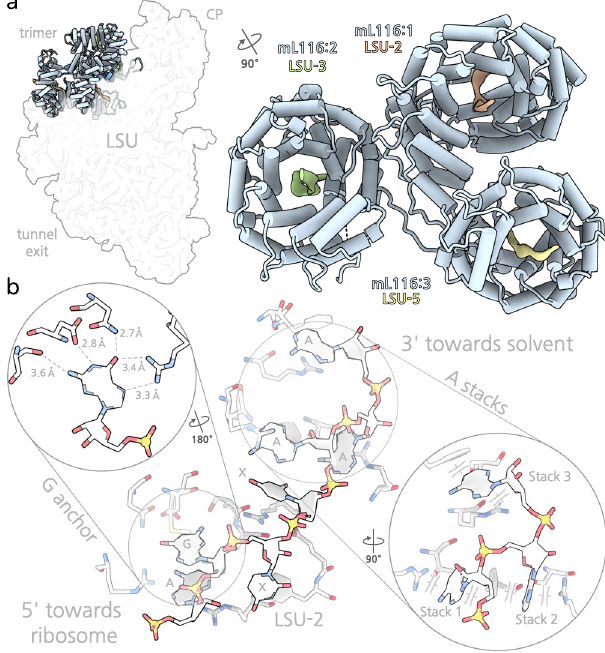
Fig. 3 | mL116 binding to rRNA motif in fragments LSU-2, LSU-3, and LSU-5. a mL116 trimer is found in the central protuberance (CP). Each copy binds a 3 ′ terminusofrRNAfragment(LSU-2,LSU-3,LSU-5)initscentralgroove. b Eachoneof the three mL116 monomers in the central protuberance of the LSU binds a 3 ′ terminusofrRNAviathemotifGXXAAA.Aspeci fi cguaninebindingsitefollowedby three adenine bases stacked between arginine and phenylalanine. Insets showing contact distances and speci fi c guanine binding aswell asalternative stacking view.